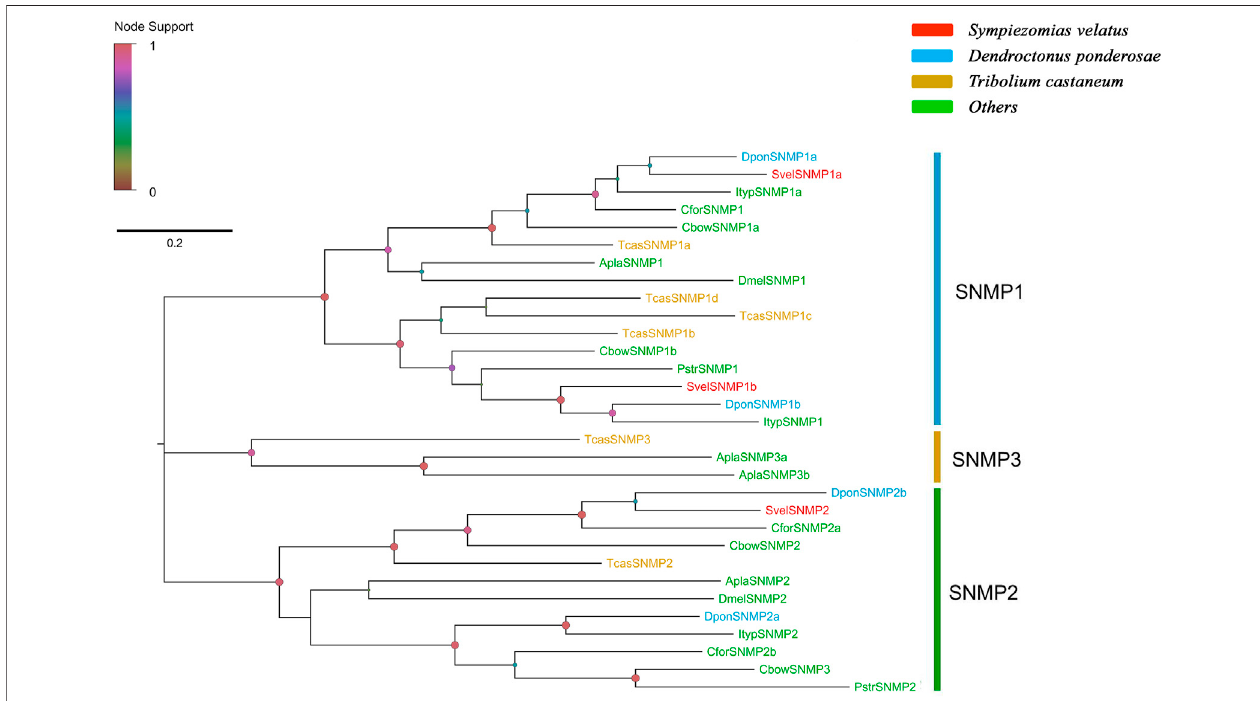
FIGURE 6 | Phylogenetic tree of the candidate sensory neuron membrane proteins (SNMPs). The SNMP sequences included were from Sympiezomias velatus (Svel, red), Dendroctonus ponderosae (Dpon, blue), Tribolium castaneum (Tcas, yellow), and other species (green), including Drosophila melanogaster (Dmel), Agrilus planipennis (Apla), Colaphellus bowringi (Cbow), Cylas formicarius (Cfor), Ips typographus (Ityp) and Phyllotreta striolata (Pstr). The tree was constructed using FastTree based on a MAFFT alignment. The local support values based on the Shimodaira-Hasegawa (SH) test are indicated by the colored circles and increase with the brightness and size of the